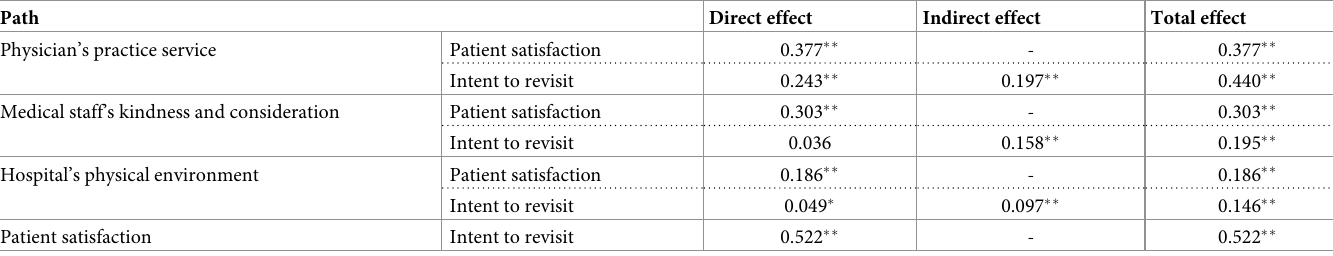
Table 4. Effect analysis